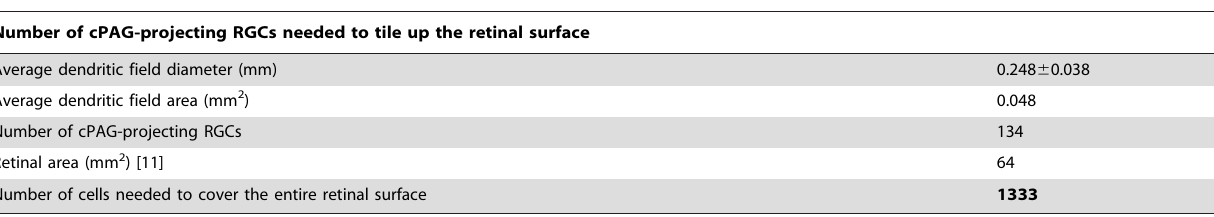
Table 1. Number of caudal periaqueductal gray (cPAG)-projecting retinal ganglion cells (RGCs) required to tile up the retinal